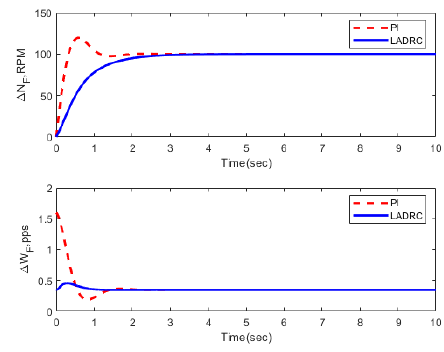
Figure 16. Step response of FC07.